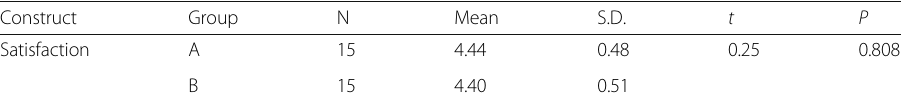
Table 9 The result of t-test in satisfaction Construct